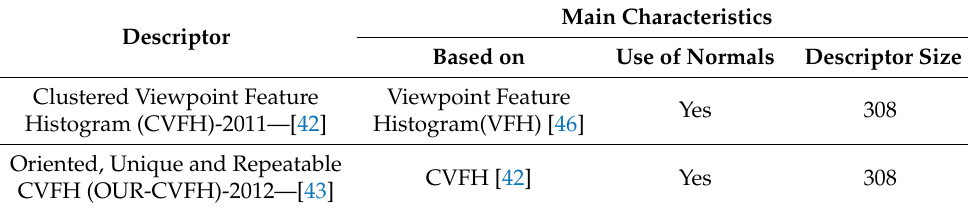
Table 2. Summarized characteristics of the two descriptors used in this paper, respectively CVFH and OUR-CVFH. The “based on” column indicates if the descriptor evolved directly from another approach. The “use of normals” indicates whether the method uses surface normals for computing the descriptor, while the last column indicates the length of the descriptor